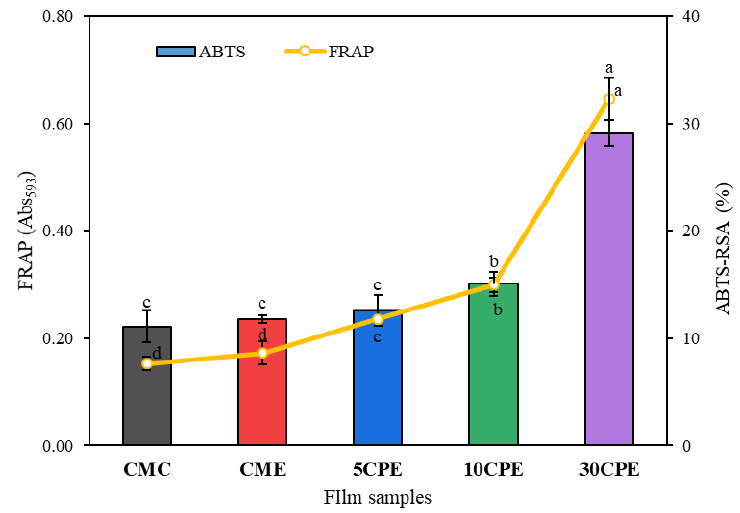
Figure 8. FRAP and ABTS antioxidant activities of films. Values represent mean ± SD ( n = 3), and different superscripts denote significant differences (DMRT, p < 0.05).